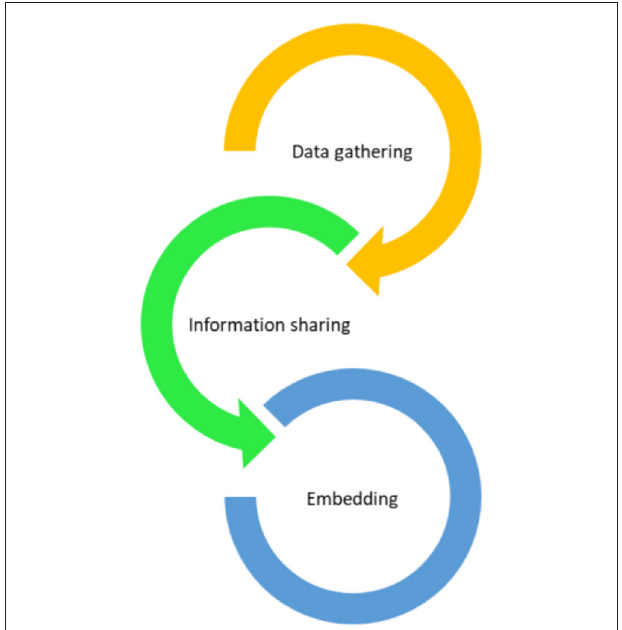
FIGURE 5 | Dynamics between elements −